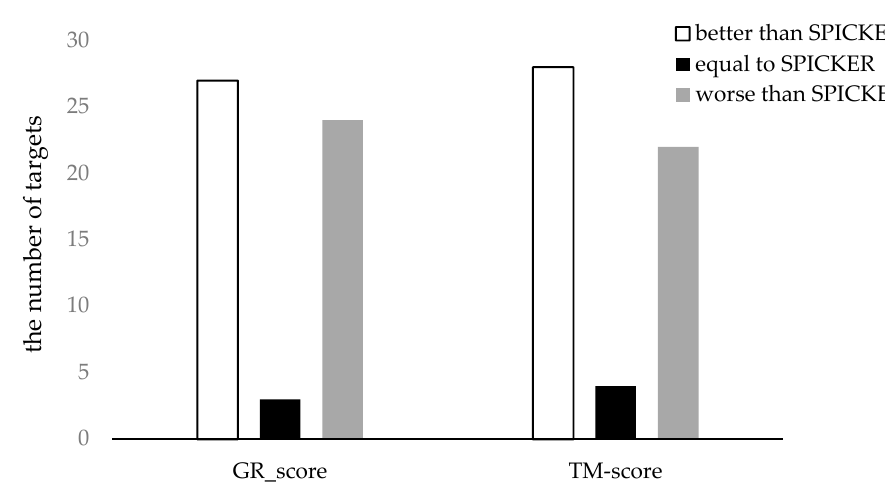
Figure 7. The comparison of the two methods using both GR_score and TM-score for datasets from CASP11.